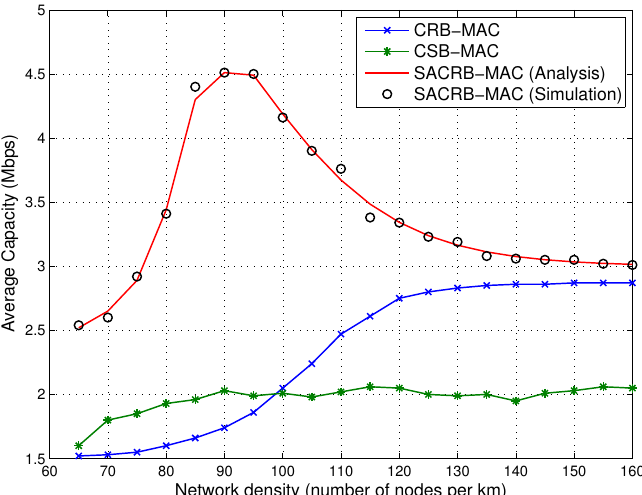
Figure 6. Average capacity performance against network density.